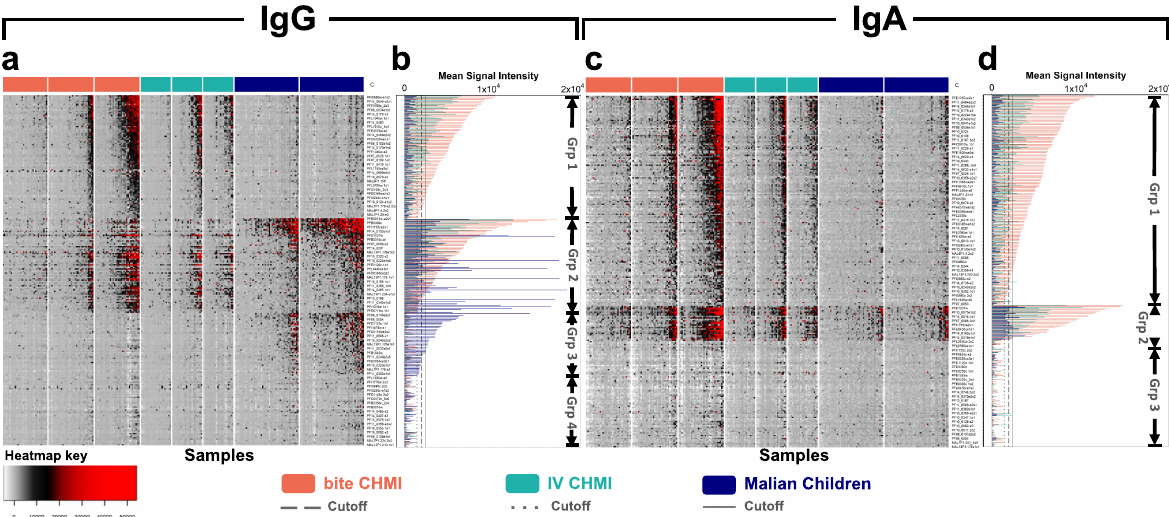
Fig. 1 Heatmaps of P. falciparum antibody responses in three clinical studies. Fluorescence intensities (FI) for IgG ( a ) and IgA ( c ) (in rows; 228 and 193 antigens for IgG and IgA, respectively), and serum samples (in columns). Bar graphs for IgG ( b ) and IgA ( d ) show mean reactivity for each study cohort and antigen at day + 29 for CHMI studies and the post-infection timepoint for Malian children. Cutoff lines for each cohort indicate the threshold average FI above which the cohort is considered to have reacted to that antigen. Samples were collected at baseline, day + 15, and day + 29 for the bite CHMI ( n = 32); baseline, day + 29, and day + 57 for the intravenous (IV) CHMI ( n = 22); and pre- and post- infection for Malian children ( n = 47). Each FI is the raw value minus the mean of the 7 no-DNA control spots. For each group and timepoint, samples are arranged with increasing reactivity from left to right; antigens are arranged by decreasing reactivity from top to bottom in three groups. Groups (Grp) delineate antigen reactivity among cohorts as follows: IgG ( a , b ) Grp 1, antigens that are reactive in CHMI participants but not in Malian children; Grp 2, antigens reactive in both CHMI participants and Malian children; Grp 3, antigens reactive in Malian children but not CHMI participants (IgG), Grp 4, antigens that were non-reactive. IgA ( c , d ) shows only three groups; Grp 1, reactive antigens in CHMI participants but not in Malian children; Grp 2, reactive antigens in both CHMI participants and Malian children; and Grp 3, non-reactive antigens. Heatmap key contains FI color